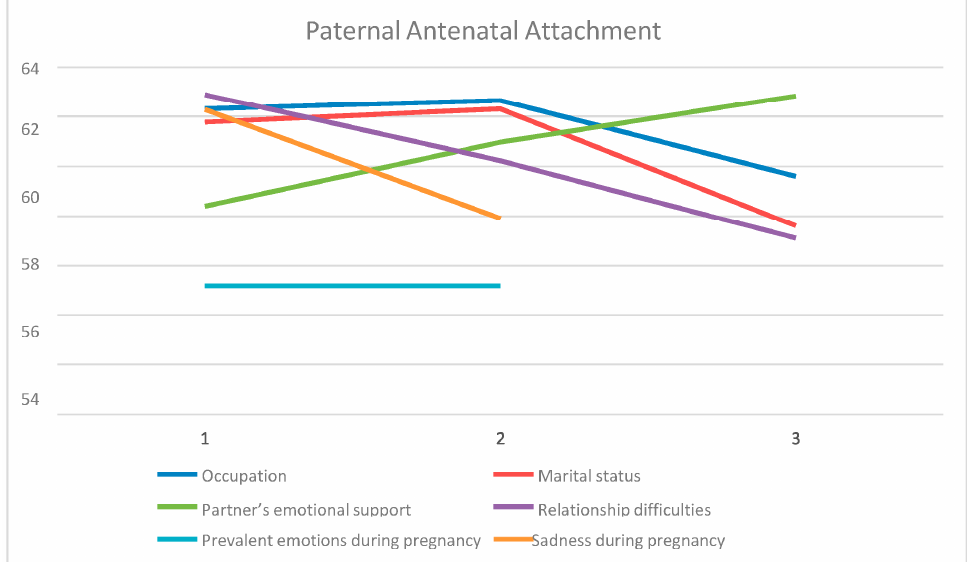
Figure 1. The relationship between paternal antenatal attachment and independent variables.